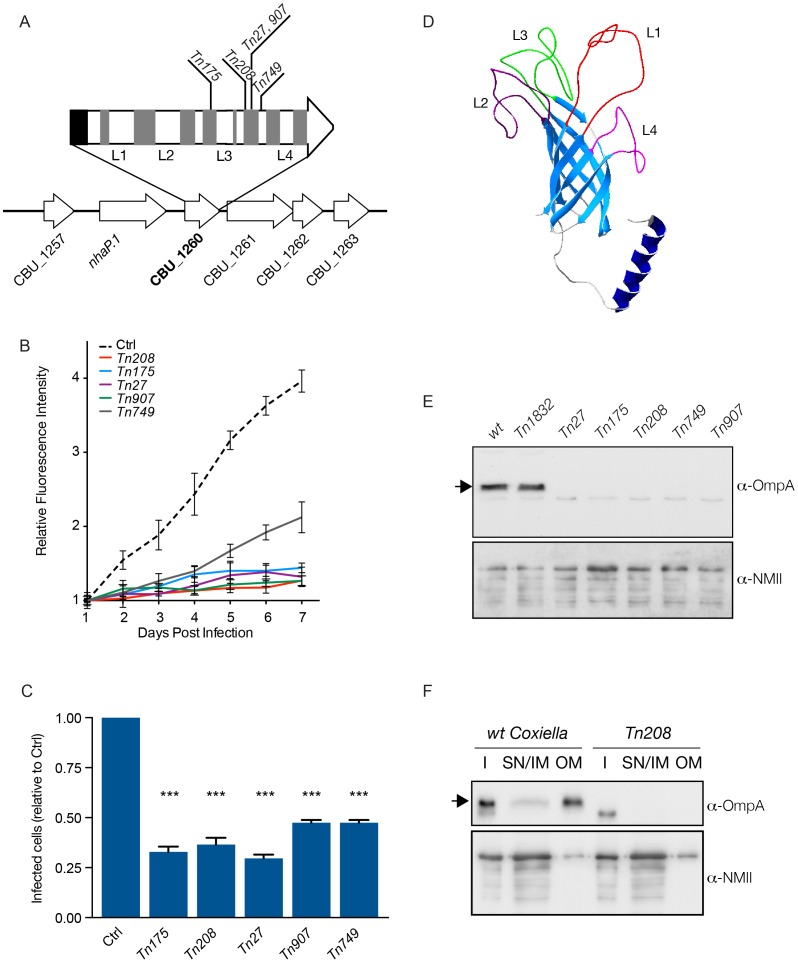
Characterization of CBU_1260 (OmpA), a Coxiella protein involved in host cell invasion.(A). Schematic representation of the genomic context of CBU_1260 and sites of transposon insertion of 5 independent isolated mutants (Tn175, Tn208, Tn27, Tn907, Tn749). Black area indicates the position of the predicted N-terminal α-helix and grey areas indicate the position of predicted β-sheets. Predicted extracellular loops are indicated from L1 to L4. (B). Intracellular growth curves of Coxiella mutants containing transposon insertions in CBU_1260 measured as variation of GFP fluorescence over 7 days of infection and compared to GFP-tagged wt Coxiella (Ctrl). The growth curves of all CBU_1260 mutants were significantly different from that of GFP-Coxiella (P<0.001, 2way ANOVA) from day 2 post-infection. (C). For each CBU_1260 mutant analyzed, the total number of Coxiella colonies identified by automated image analysis was divided by the total number of cell nuclei and expressed as relative to GFP-tagged wt Coxiella (Ctrl) to derive the efficiency of host cell invasion. Values are mean ± standard deviation of triplicate samples where an average of 12000 cells were analyzed per condition (values were compared with Ctrl condition. *** = P<0.001, 2way ANOVA). (D). iTASSER-derived prediction the CBU_1260 product. The central core of the protein is composed of an 8-β-sheet transmembrane barrel domain (light blue). The putative periplasmic domain is composed of a α-helix (dark blue), whereas the predicted extracellular domain is composed of four (L1 to 4) unstructured loops. (E). Representative Western blot of bacterial lysates from wt Coxiella, the control mutant Tn1832 and the 5 mutants presenting transposon insertions in CBU_1260. (F). Representative Western blot of wt Coxiella and mutant Tn208 subjected to membrane fractionation to assess the localization of OmpA (I = insoluble fraction; SN/IM = supernatant and inner membrane fraction, OM = outer membrane fraction). Blots were revealed with an antibody raised against the first extracellular loop (L1) of OmpA (top panels) and with a polyclonal antibody against Coxiella NMII (bottom panels) used as loading control. The arrows indicate the expected size of OmpA (23 kDa).